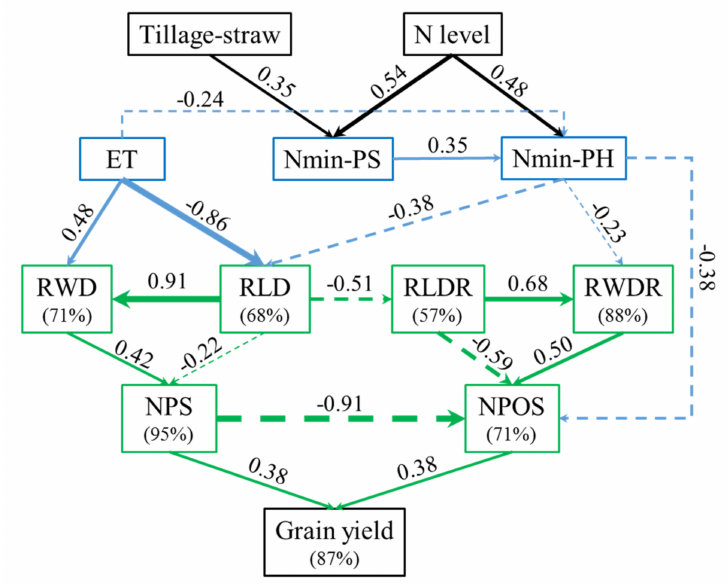
Figure8. Structuralequationmodelshowingthepotentialmechanismoftillagewithstrawincorporation and N rate management related to the maize yield over two years ( χ 2 = 2.644, df = 5, p = 0.755, CFI = 1.000, GFI = 0.993, RMSEA = 0.000). Continuous and dashed arrows indicate positive ( p < 0.05) and negative ( p < 0.05) relationships, respectively. Numbers (standardized path coe ffi cients) on the arrows that follow the included variables show the explained percentage of variance by the predictors. The width of arrow indicates the strength of the standardized path coe ffi cient. Field evapotranspiration (ET), soil mineral N storage in the 0–60 cm soil layer at pre-sowing (Nmin-PS), soil mineral N storage in the 0–60 cm soil layer at post-harvest (Nmin-PH), root length density (RLD) in the 0–60 cm soil layer, root weight density (RWD) in the 0–60 cm soil layer, ratio of root length density (RLDR) in the 0–30 cm soil layer, ratio of root weight density proportion (RWDR) in the 0–30 cm soil layer, pre-silking shoot N uptake (NPS), and post-silking shoot N uptake